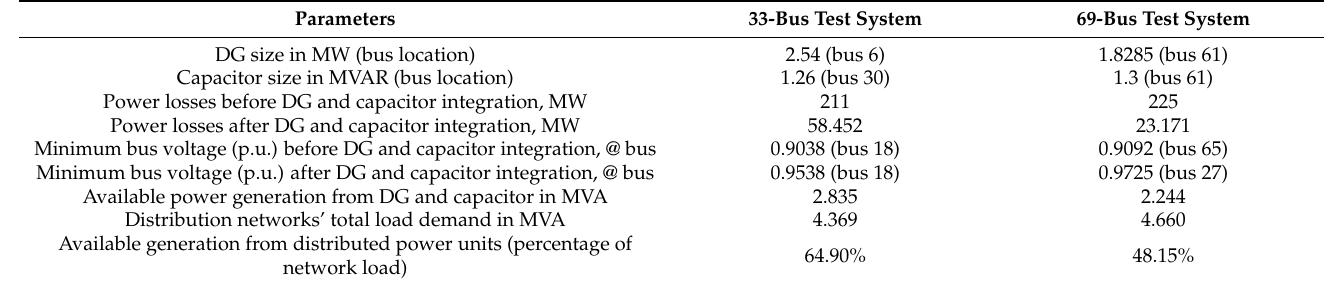
Table 2. The results of simultaneous DG–capacitor allocation in 33-bus and 69-bus test systems.